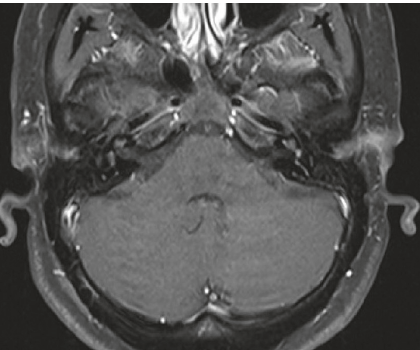
Figure 1: MRI T1 axial postcontrast imaging demonstrating bi- lateral enhancement of the cochlea, vestibule, and semicircular